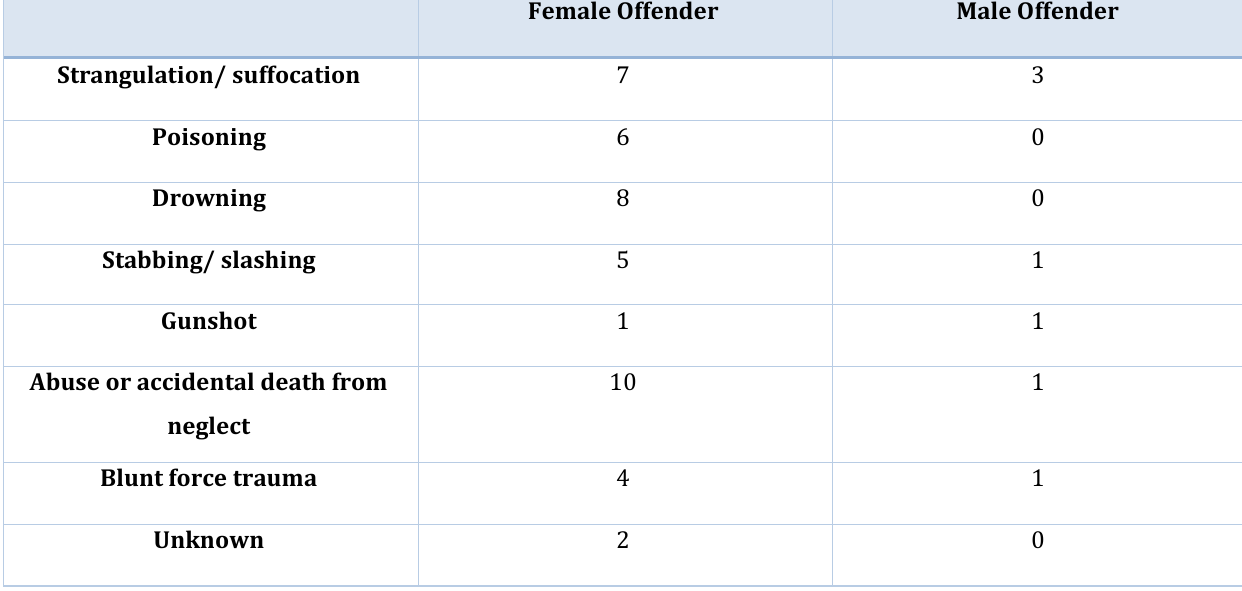
Table 4: Cause of Death, Filicides in Victoria, 1860 –